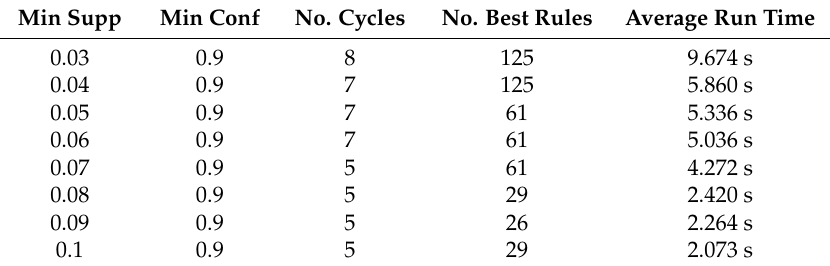
Table 1. Travel route recommendation performance evaluation.